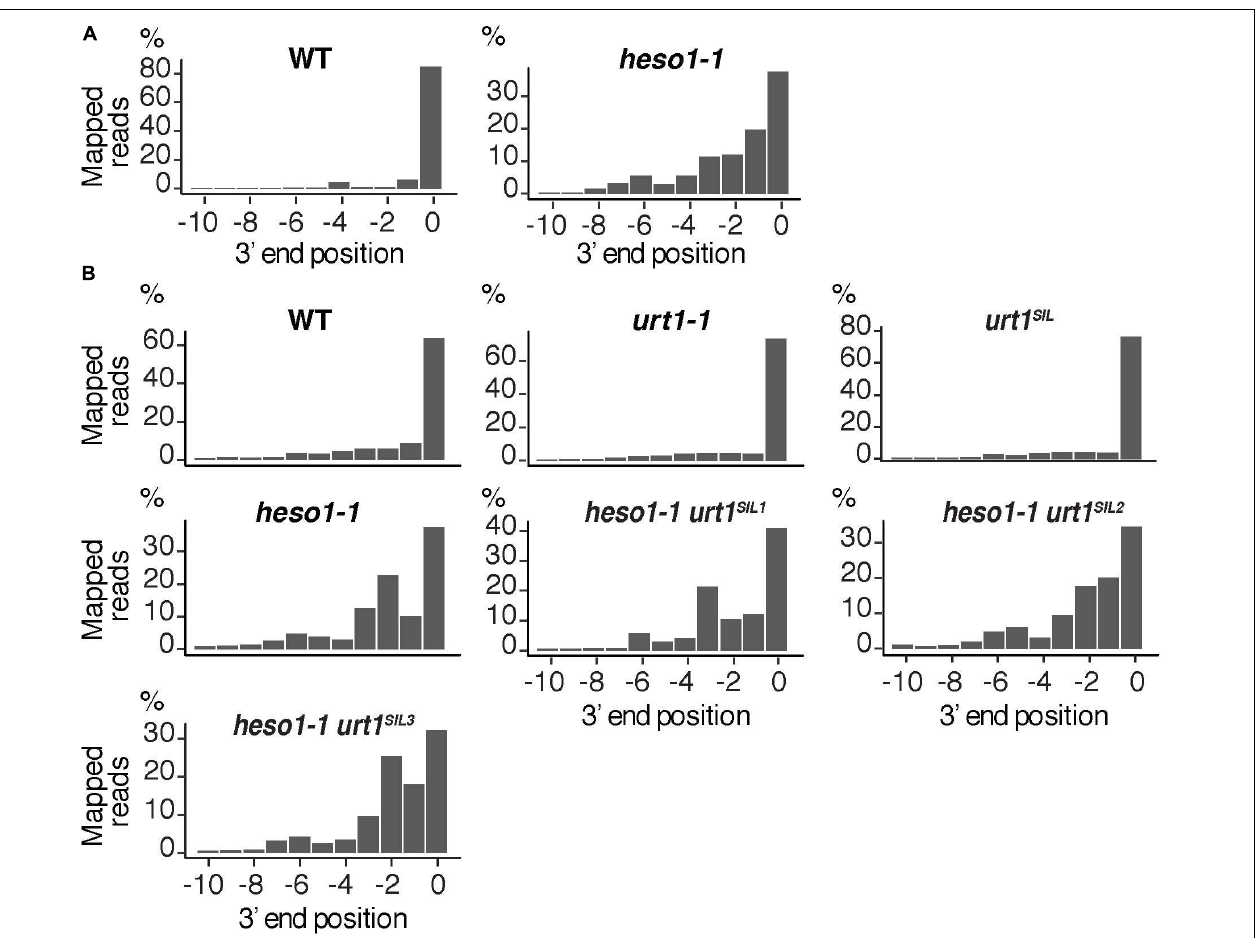
FIGURE 6 | Nibbled MYB33 RISC 5 (cid:48) -cleavage fragments accumulate in the absence of HESO1. Positions of 3 (cid:48) extremities of MYB33 RISC 5 (cid:48) -cleavage fragments mapped in a –10/0 window for (A) four biological replicates, WT and heso1-1 , or (B) two biological replicates for WT, urt1-1 , the urt1 SIL line, heso1-1 , and the three heso1-1 urt1 SIL lines. Graphs are shown separately for each of the replicates in Supplementary Figures S3 , S4 .